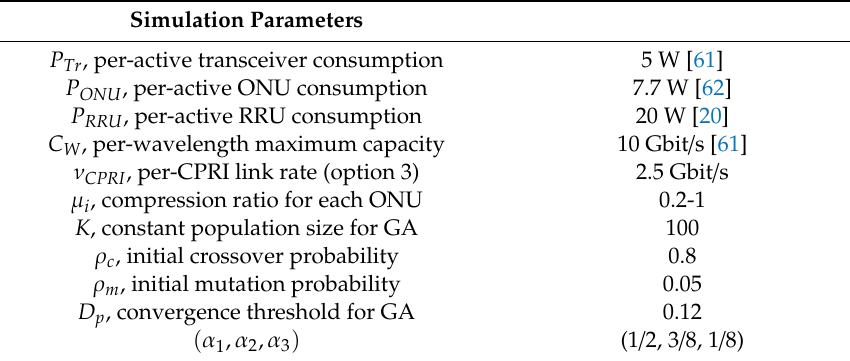
Figure 2. Traffic variation during an operational day [55].